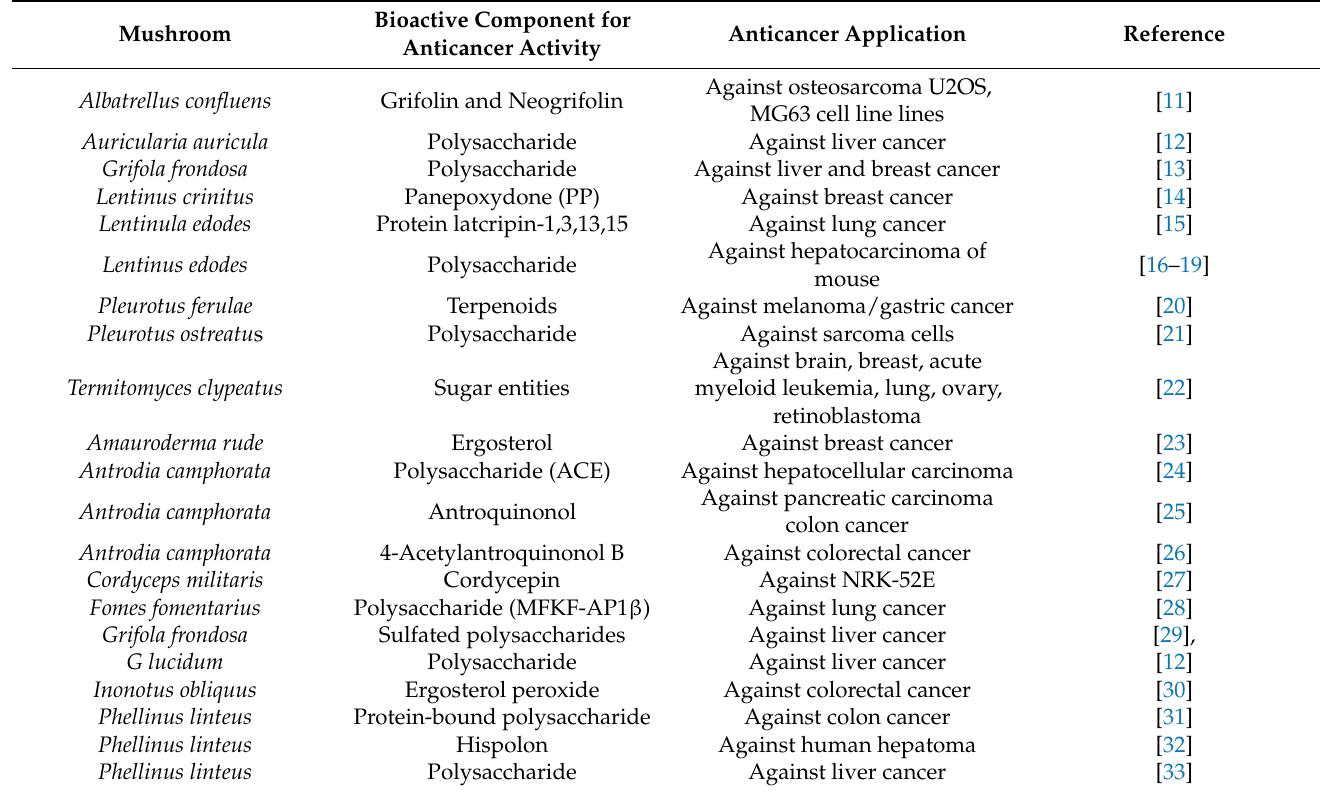
Table 1. Consolidated list of anticarcinogenic